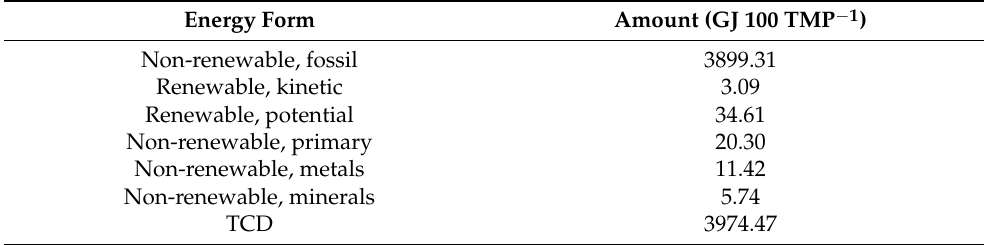
Table 5. CExD energy forms result analysis for 100TMP in the studied